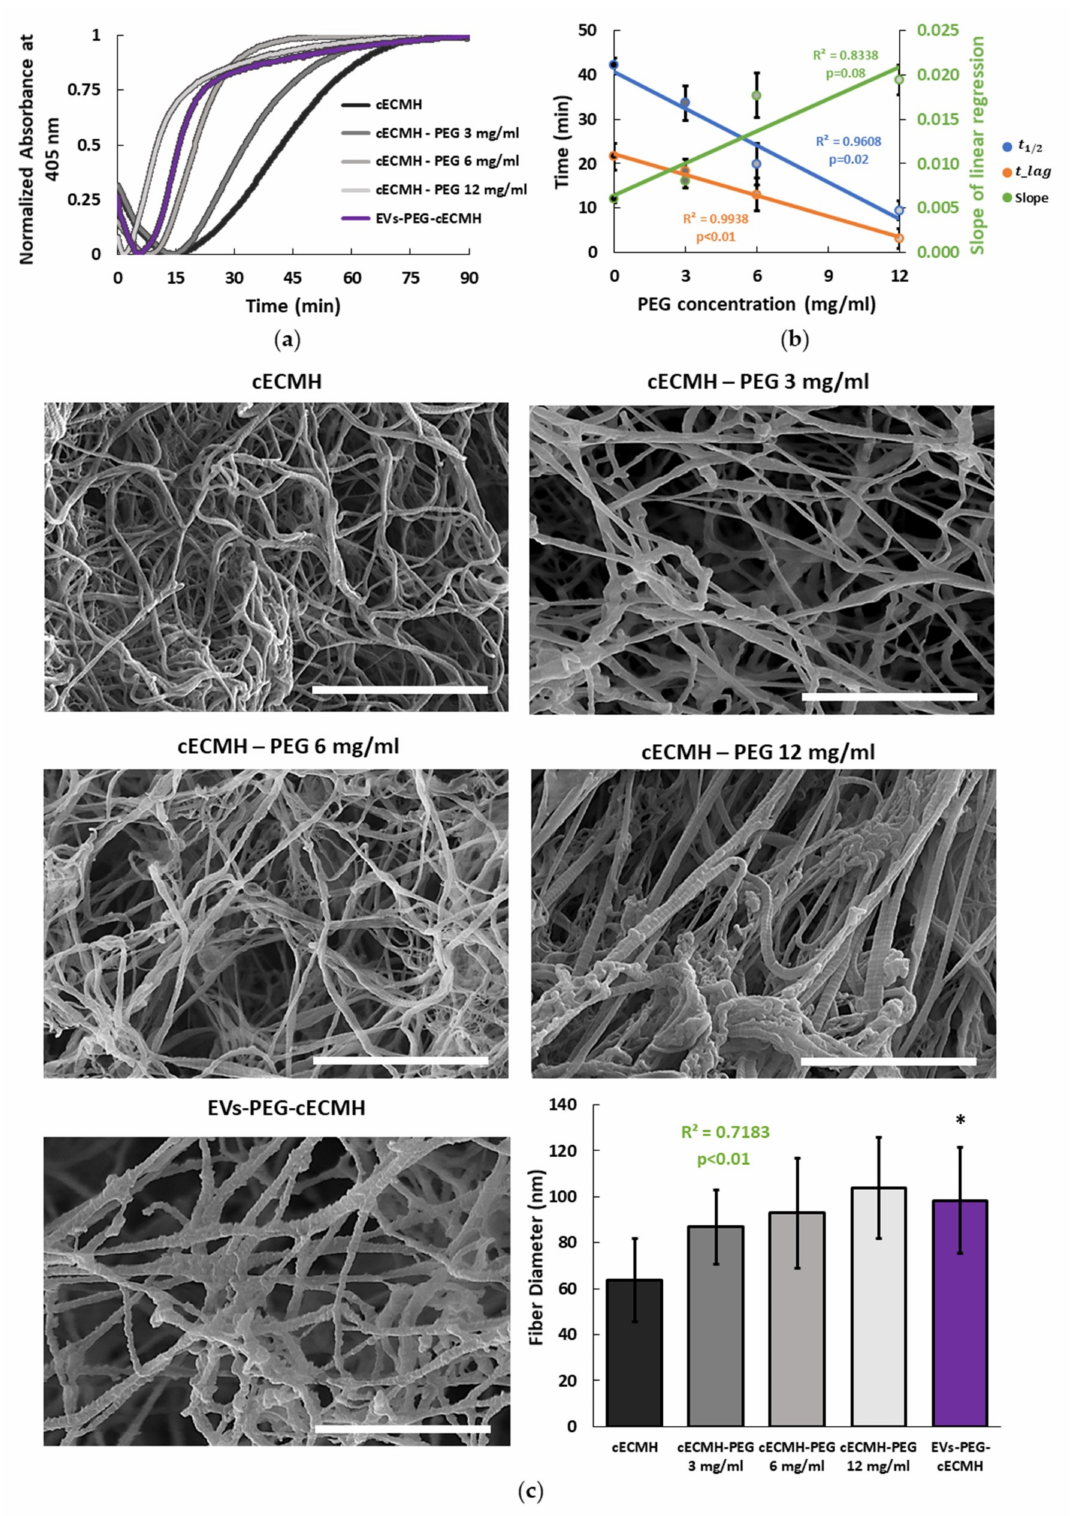
Figure 2. Gelation kinetics and fiber diameter. ( a ) Turbidimetric average results over time, with optical density normalized at 405 nm for the different formulations ( n = 3, each in triplicate, for each condition). ( b ) Correlation between the PEG concentration and the half gelation time (t 1/2 ) , the lag time (t lag ), and the slope of the linear regression (speed of gelation) obtained from turbidimetry ( n = 3, each in triplicate, for each condition). ( c ) Scanning electron microscopy (SEM) images of the different hydrogel formulations and their average fiber diameter ( n = 160 fibers for each condition). Scale bars correspond to 2 µ m. Squared Pearson’s correlation coefficient for PEG concentration vs. fiber diameter and its